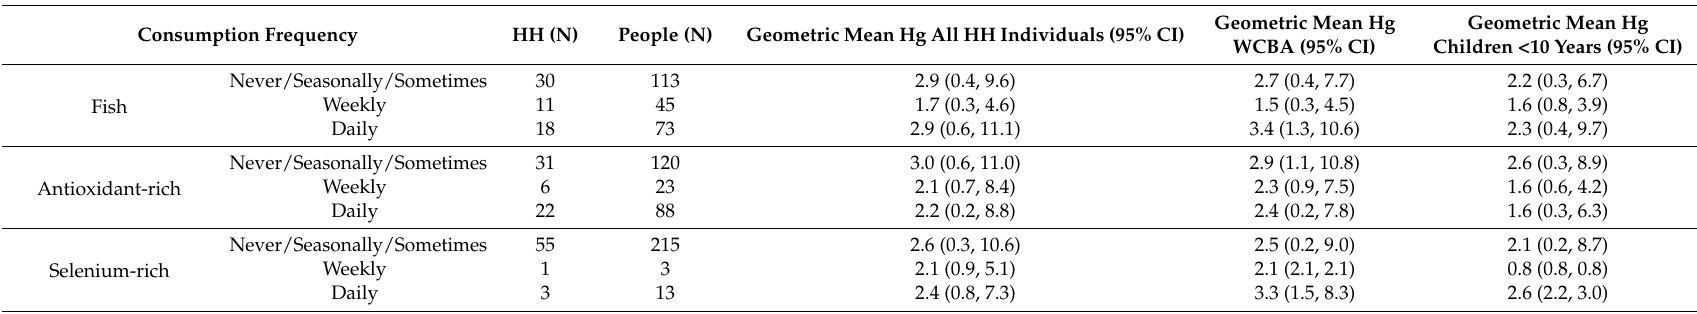
Table 2. Summary of hair mercury ( µ g/g) by household (HH) level consumption frequency of fish, antioxidant-rich (quinoa, kiwicha, tomato), and selenium-rich (Brazil nuts) diet